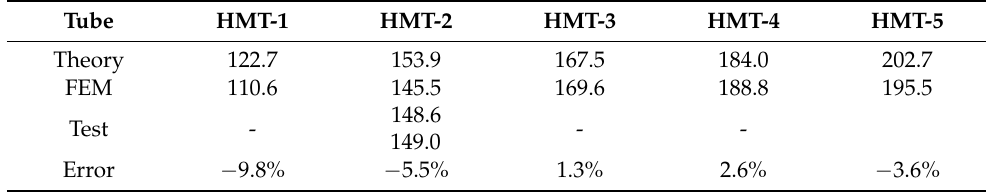
Table 9. Theoretical predicted MCFs for HMTS based on PF method.